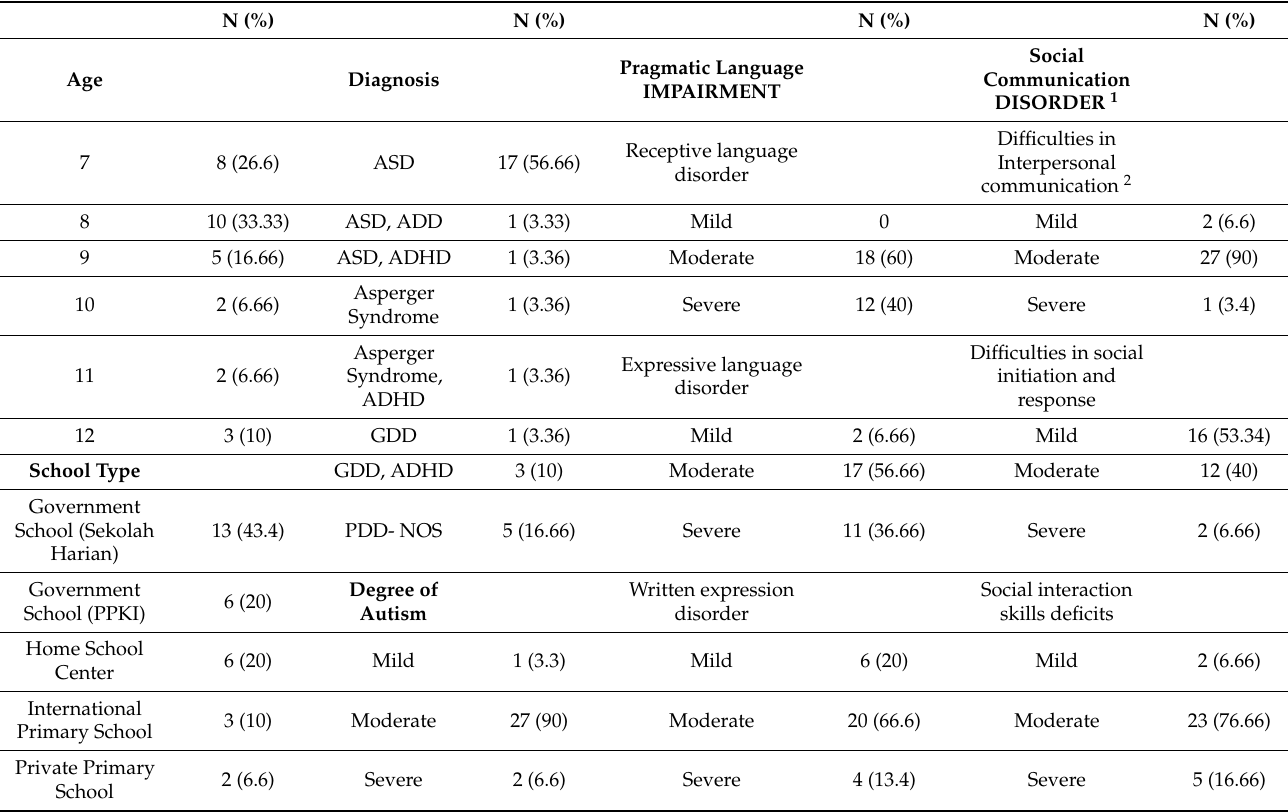
Table 1. The background characteristics of included children ( n =